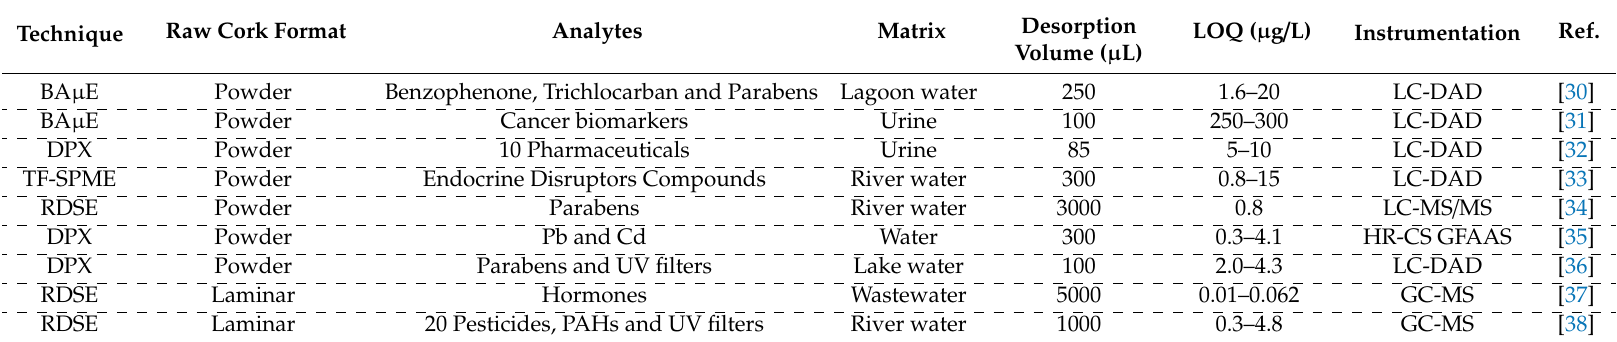
Table 1. Applications of raw cork-based microextraction techniques for di ff erent analytes and matrices. (Reference period: 2015–2019).